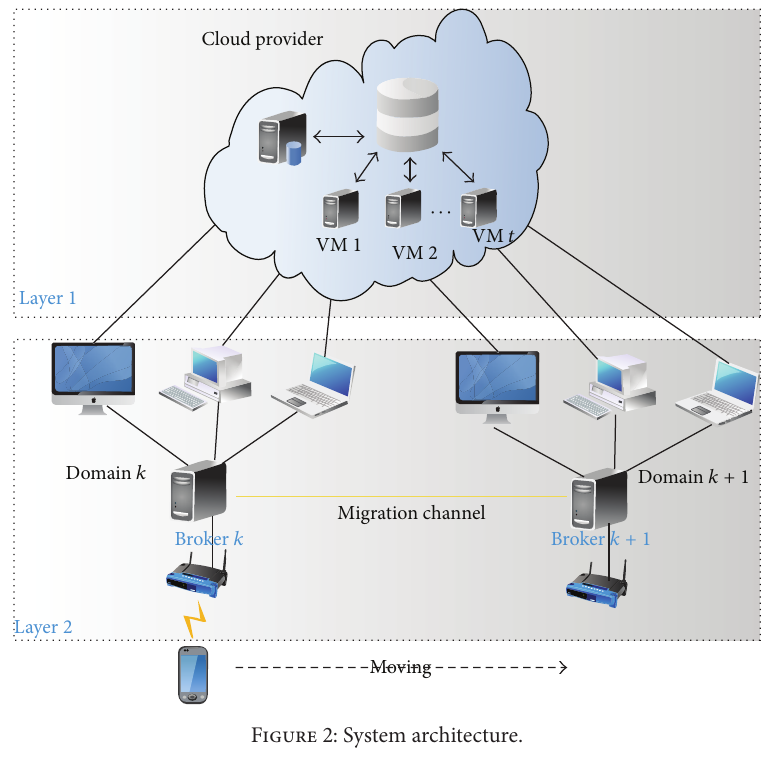
Figure 2: System